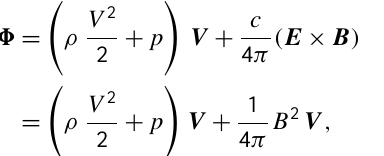
Figure 5. The planar geometry used for solving the problem. Regions 1 and 2 are the Fig. 5. The planar geometry used for solving the problem. Regions surrounding plasma and reconnection layer, respectively. Magnetic fields B 1 and 2 are the surrounding plasma and reconnection layer, respec- tively. Magnetic fields B 1 and B 2 are perpendicular to the plane perpendicular to the plane of the figure, and related to the ambient plasma and the reconnection of the figure, and related to the ambient plasma and the reconnec- layer, respectively; g is the effective gravitational acceleration. The boundary between regions 1 tion layer, respectively; g is the effective gravitational acceleration. and 2 shows an interchange disturbance on the reconnection layer upper boundary. Only upper The boundary between regions 1 and 2 shows an interchange dis- part of disturbed reconnection region is shown. turbance on the reconnection layer upper boundary. Only the upper part of the disturbed reconnection region is